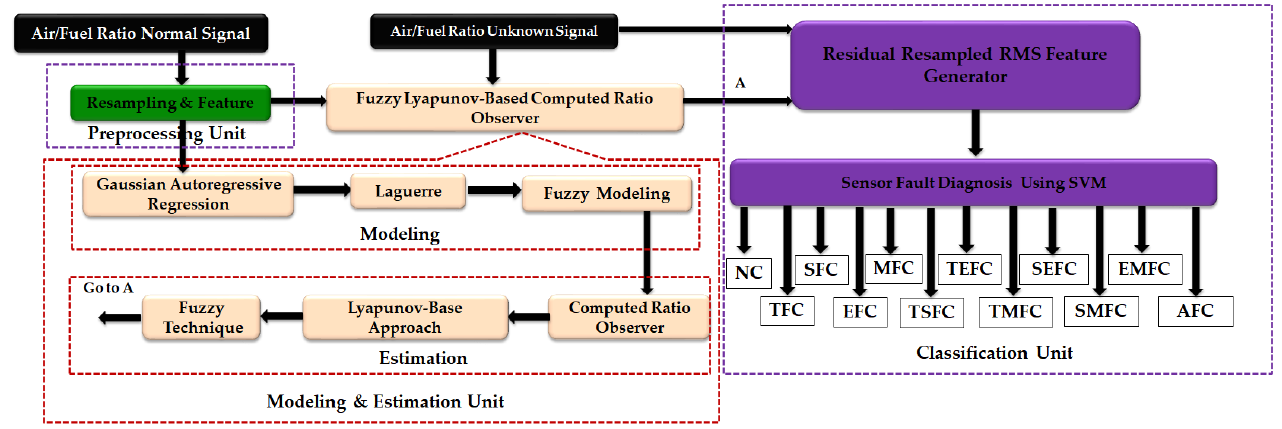
Figure 1. ICE sensor fault diagnosis using the machine fuzzy Lyapunov-based algorithm.